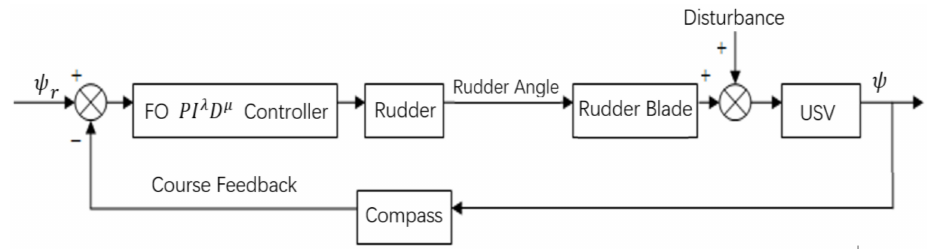
Figure 4. FO PI λ D µ control system of a ship’s